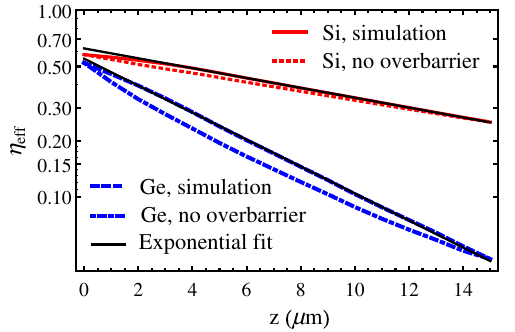
Fig. 8 Interplanar potential of (111) Si for maximal bending radius (4.76cm)usedintheexperiment.Overbarriermarksinitiallyoverbarrier fraction of particles that can be captured into the channeling mode or rechaneled (rech.) and dechanneled (capt.) once or several times